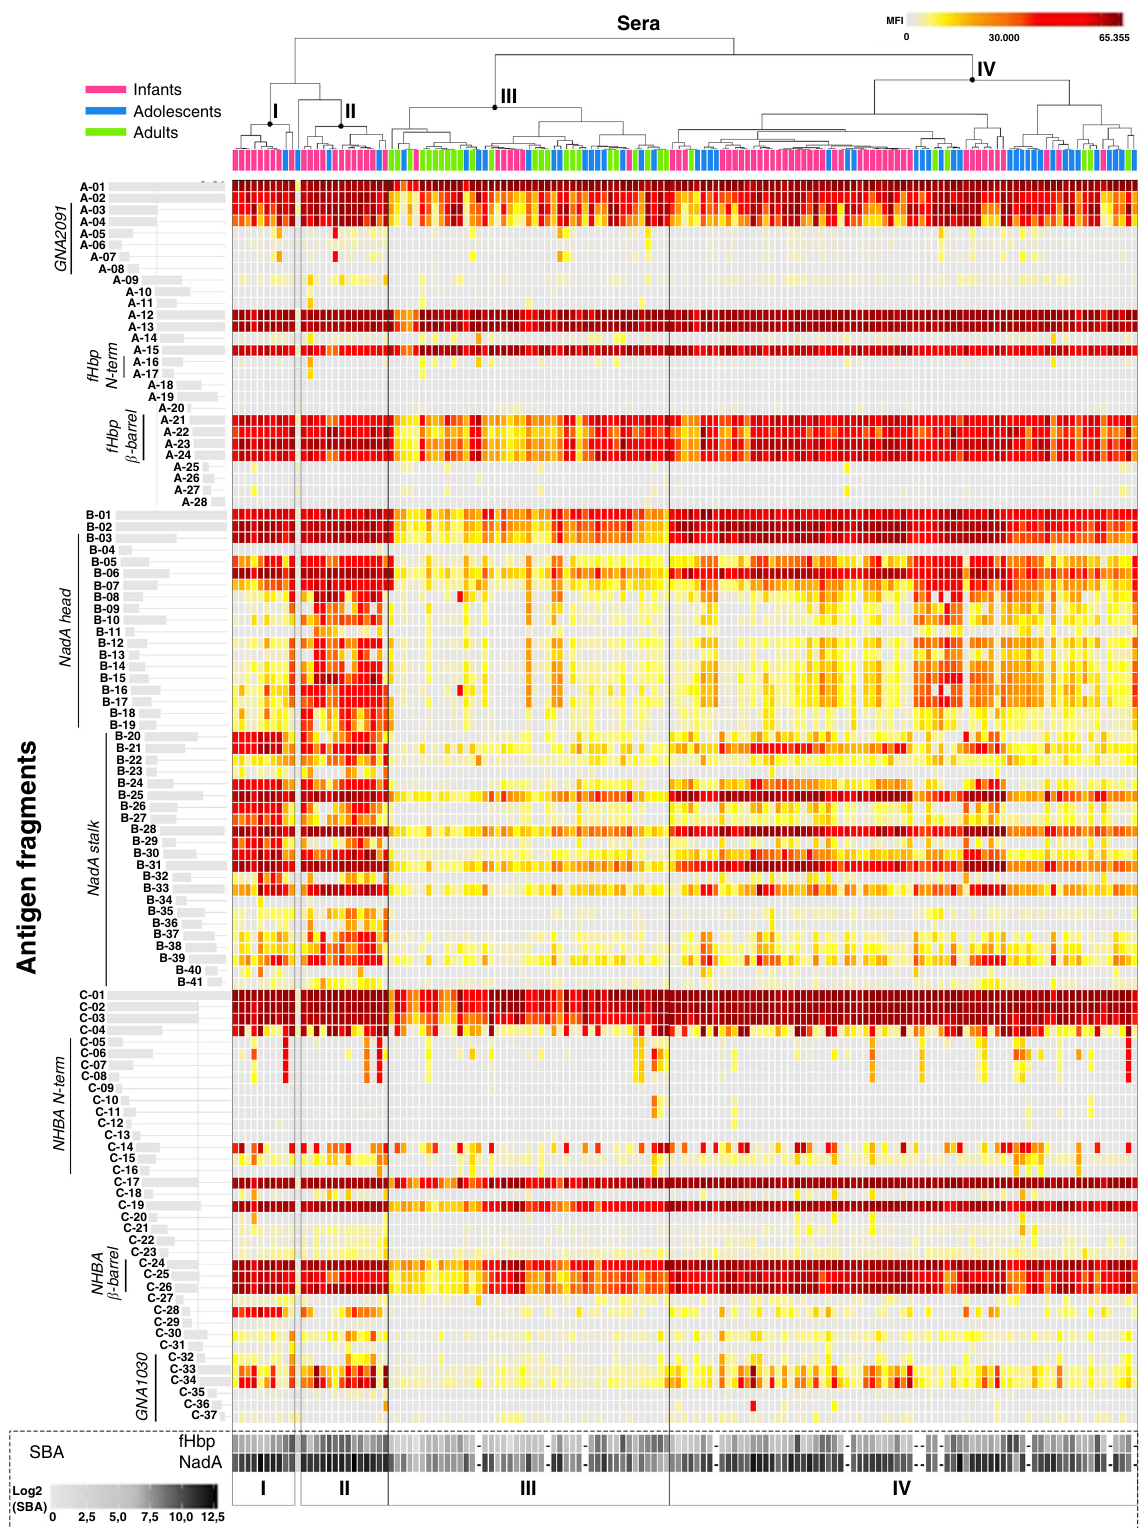
Fig. 3 Clustering analysis of protein microarray data and corresponding SBA titres. Clustering analysis of the mean fl uorescence intensity (MFI) data obtained from all antigen fragments (rows) tested against single subject sera (columns). Colour scale of signal intensity is reported on top-left of the heatmap. Subjects are coloured according to age group: in green adult subject sera, in blue sera from adolescents, and in pink sera from infants. Rectangles enclose the four major clusters composed of similar sera reactivity pro fi les. Roman numbers on the top and bottom of the fi gure identify the four sera clusters considered for subsequent analysis. Individual SBA titres of subjects against fHbp and NadA reference strains are reported below the heatmap according to a grey scale code, SBA data for ten adolescents and one adult were not available as indicated by an ‘ * ’ symbol in the same box. No NHBA reference strain was available when the studies were